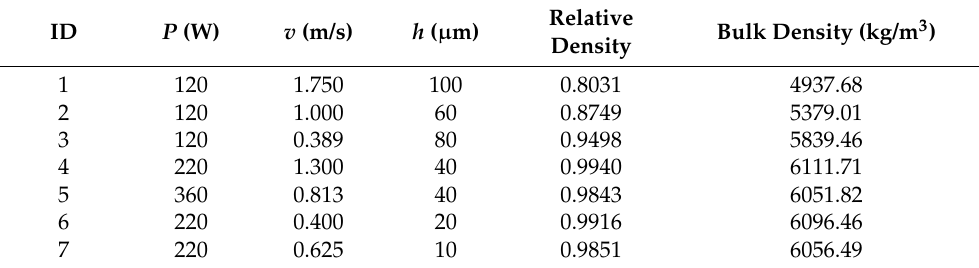
Table A14. Manufacturing parameters and experimental data adapted from [28]. Complementing relevant information and assumptions are the following; material: Ti26Nb, theoretical density